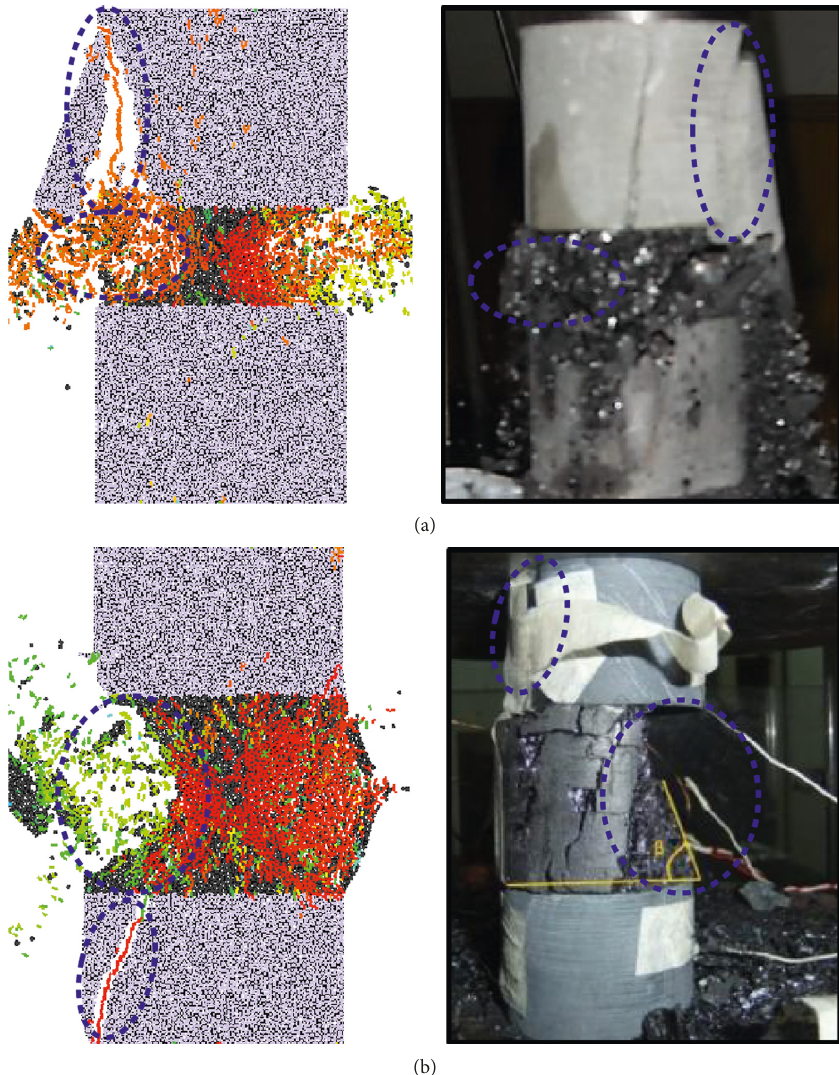
Figure 15: Comparison between the simulation results (left) and the laboratory test results (right). (a) Failure mode of the RCR sample with a height ratio of ∼ 20%. The laboratory test result is derived from Huang and Liu [15]. (b) Failure mode of the RCR sample with a height ratio of 40%. The laboratory test result is derived from Liu et al. [16].